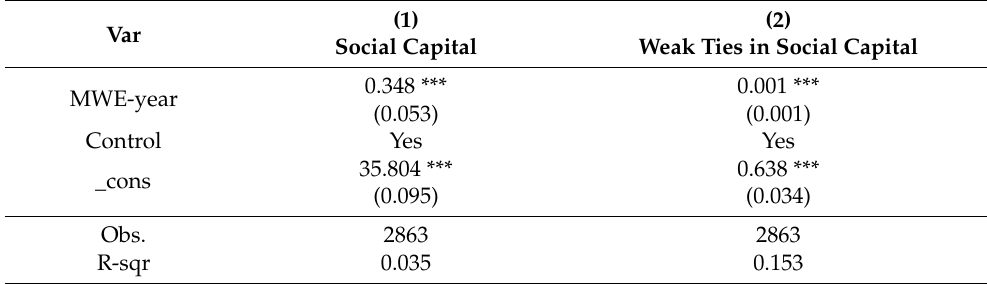
Table 7. Direct Effects of MWE-year on Social Capital and Weak ties in Social